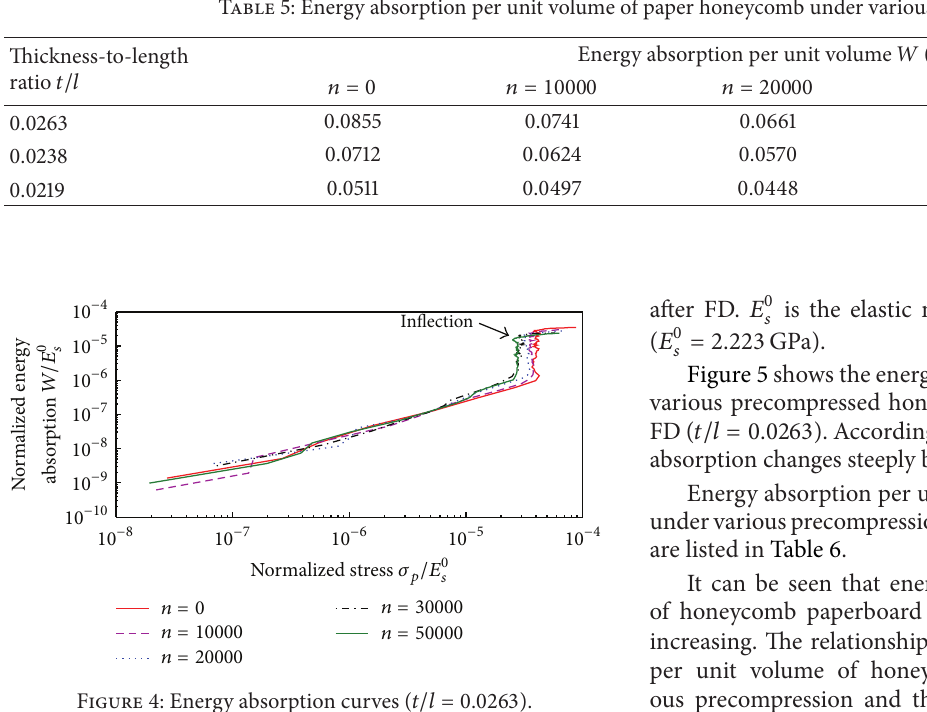
Figure 4: Energy absorption curves ( 𝑡/𝑙 = 0.0263